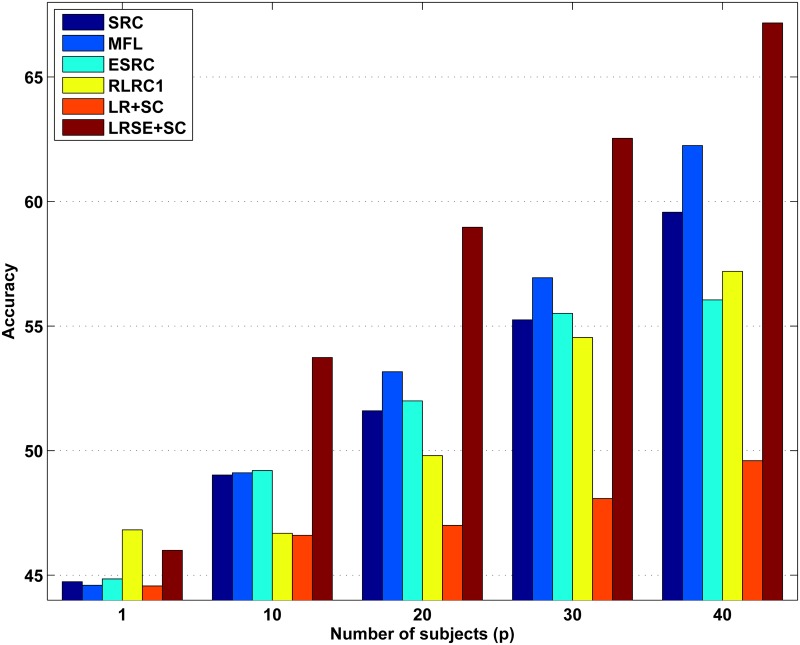
Recognition rates on AR database versus number of subjects (p).In this experiment, for each subject, 14 images with only illumination change and expression are selected. We randomly select p classes and for these subjects, all seven images at session 1 are used as training samples.